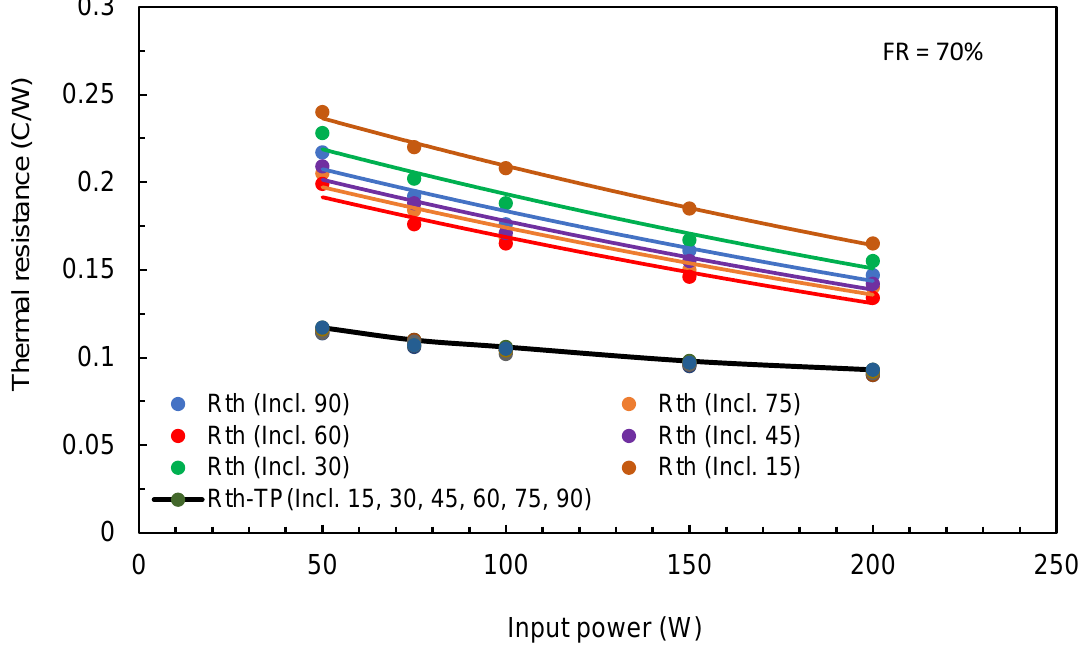
Figure 20. Variation of thermal resistance with input power for different inclination angles with and without TP (FR = 55%).